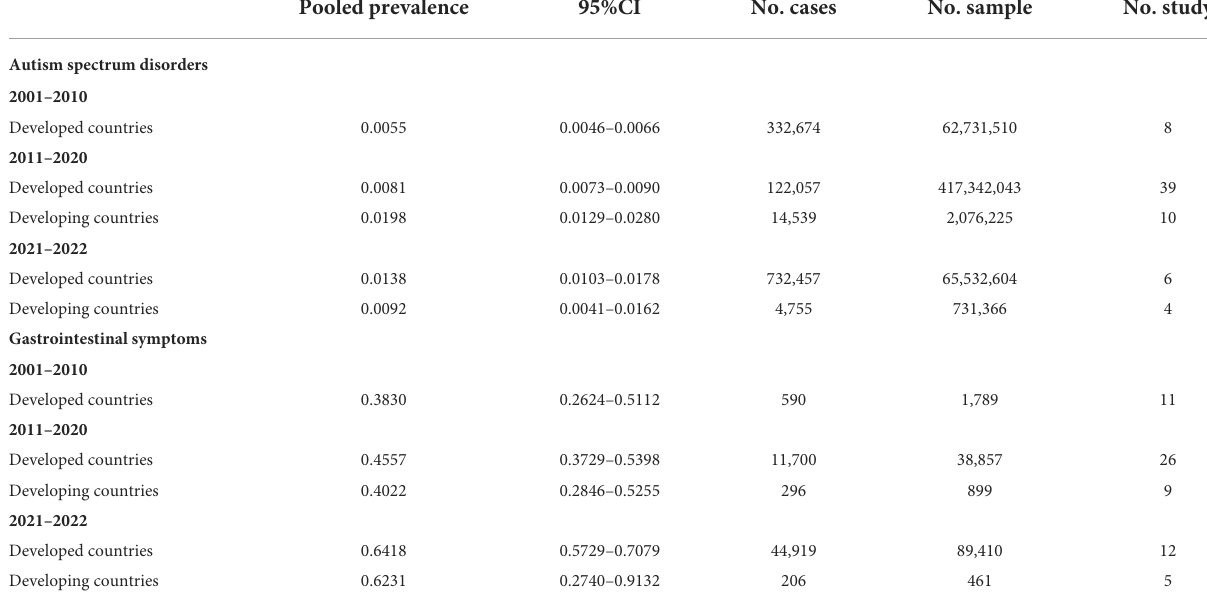
TABLE 2 Time trends in prevalence by level of